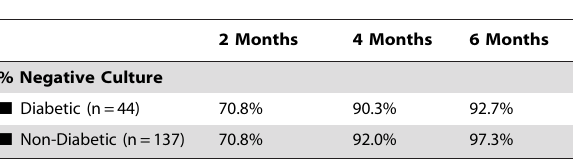
Table 4. Sputum culture conversion in cohort A.*